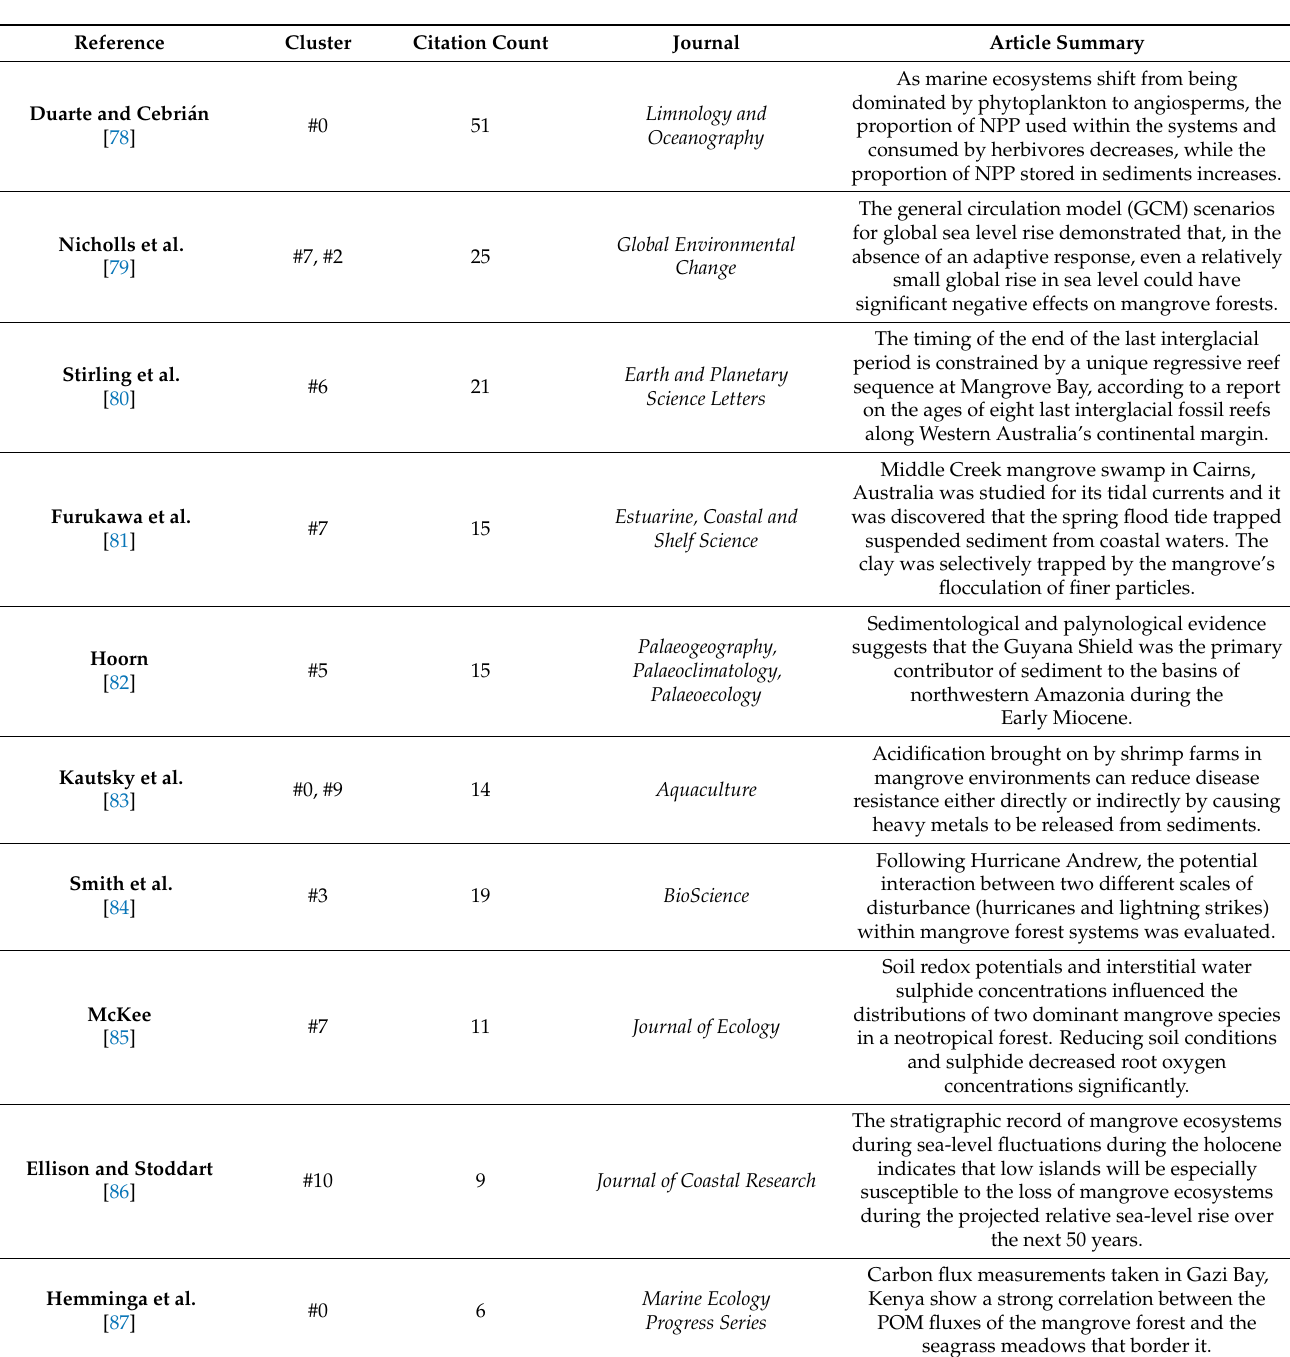
Table 6. Co-citation analysis of major citing articles pertinent to mangrove and climate change